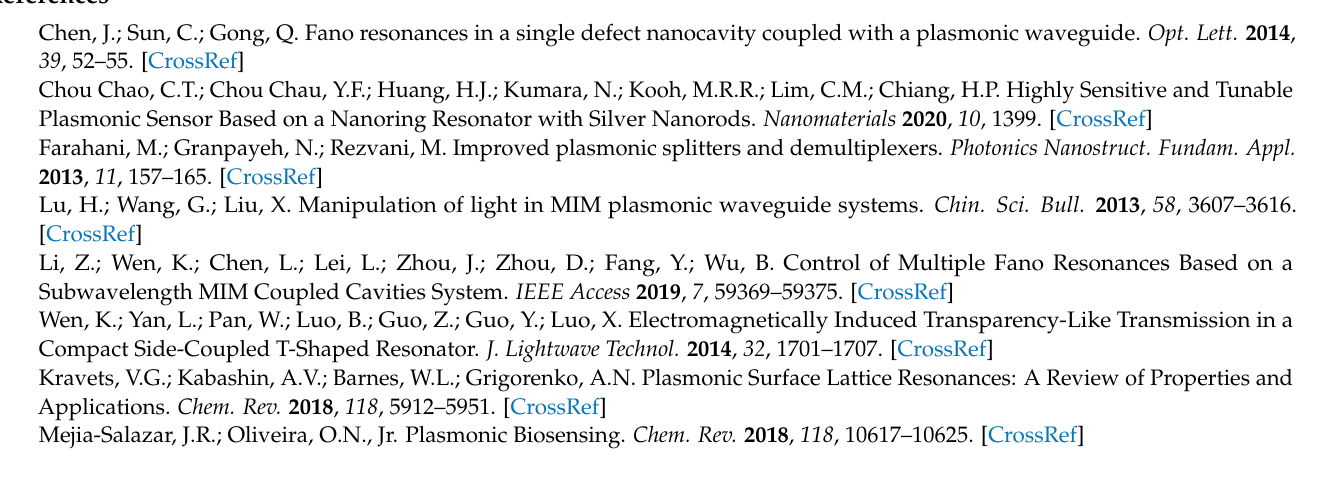
Q : represents quality factor. S : represents sensitivity. FOM : represents figure of merit. t d : represents dephasing